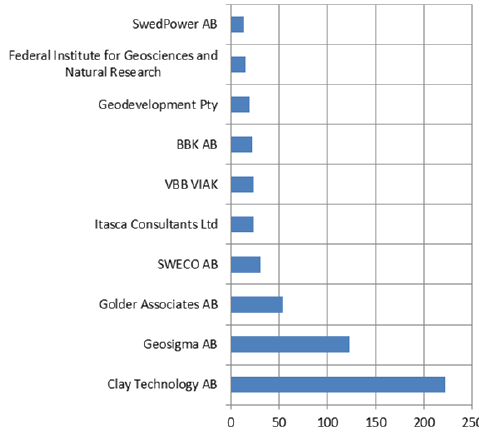
Figure 8: Number of co-authorships involving non-university organizations in publications from ¨Asp¨o hard rock laboratory